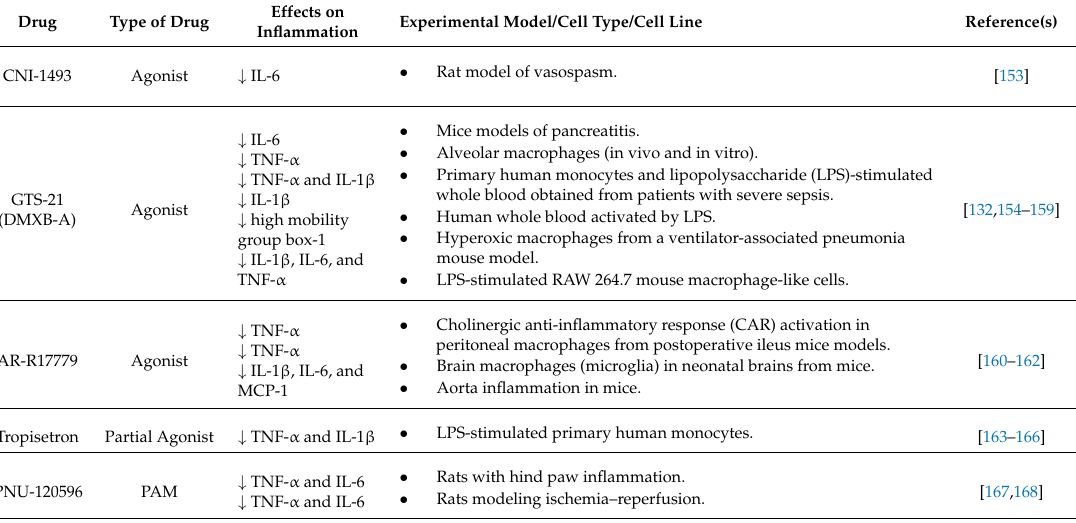
Table 1. Drugs that have proved effective in reducing macrophages’ cytokine production through alpha7 nicotinic acetylcholine receptor ( α 7-nAChR). Type of Drug Effects on